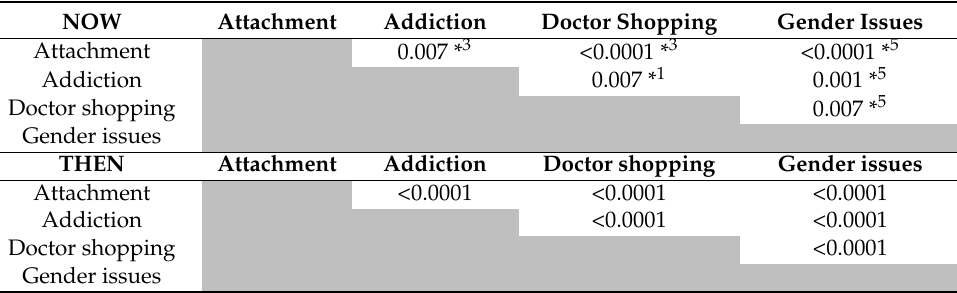
Table A11. Attachment, addiction and